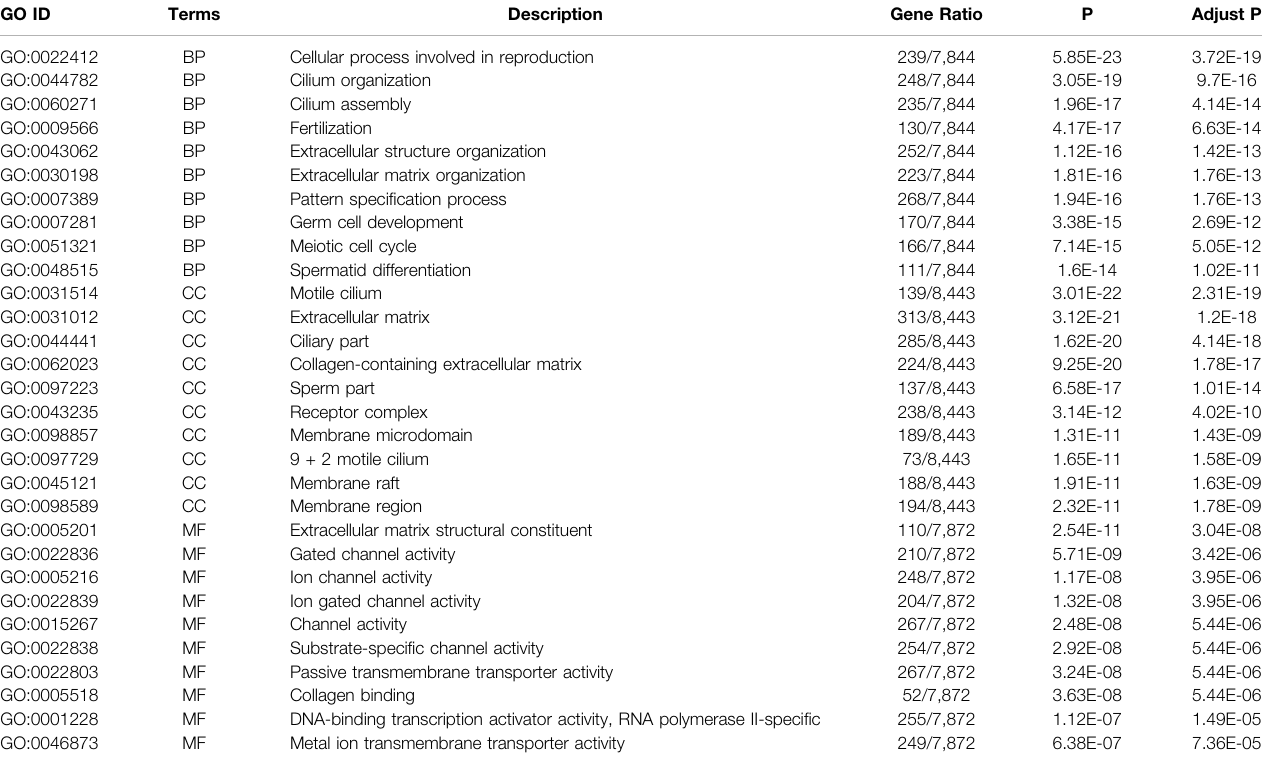
TABLE 2 | Top 10 most enriched gene ontology terms.